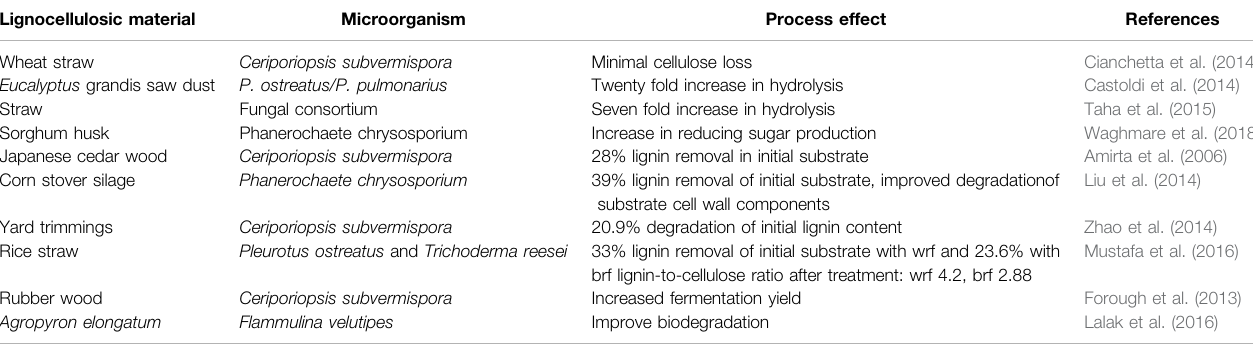
TABLE 3 | Different microorganisms reported for biological treatment of lignocellulosic